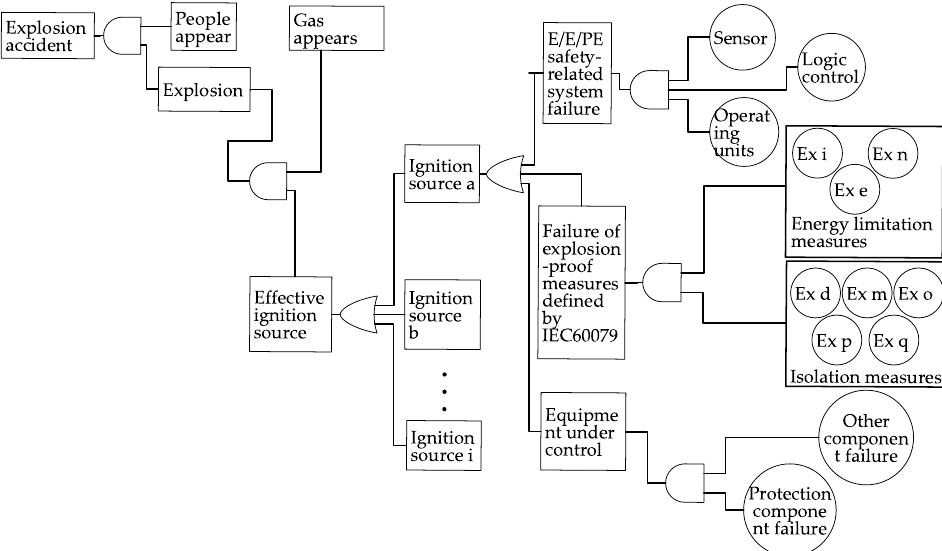
Figure 3. Explosion protection function identification based on fault tree analysis method.